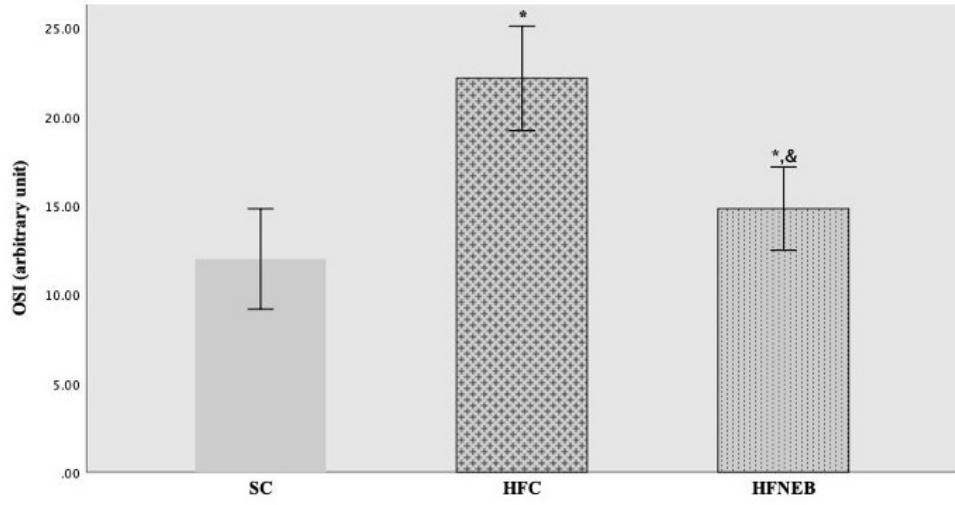
Fig. 4. Oxidative stress status of the groups (OSI ). HFC group was characterized by increased OSI. Nebivolol treatment prevented the increase in OSI ( p < 0.05 *compared to SC, & compared to HFC).